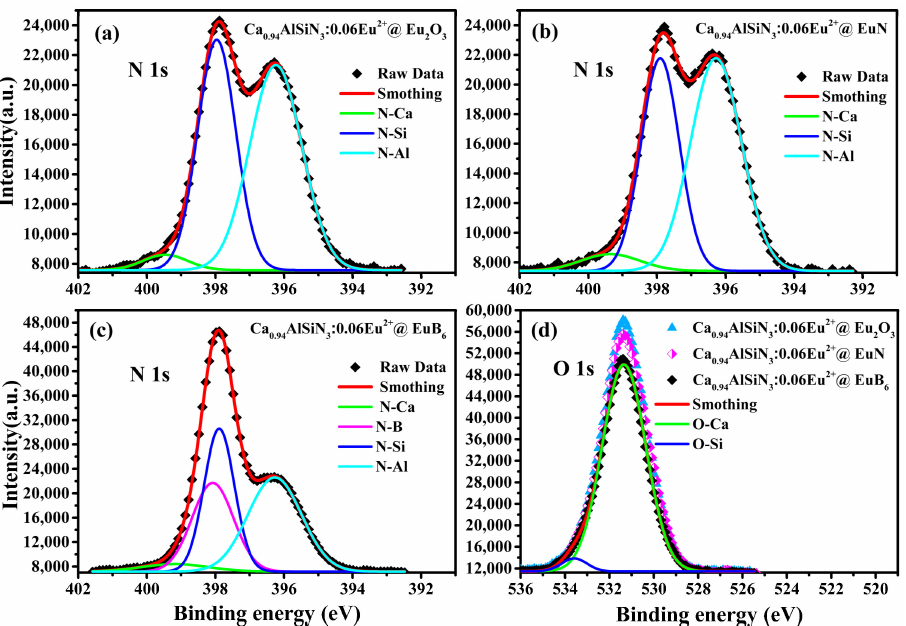
Figure 5. The XPS spectra of O 1s and N 1s Ca 0.94 AlSiN 3 :0.06Eu 2+ @Eu 2 O 3 , Ca 0.94 AlSiN 3 :0.06Eu 2+ @EuN and Ca 0.94 AlSiN 3 :0.06Eu 2+ @EuB 6.